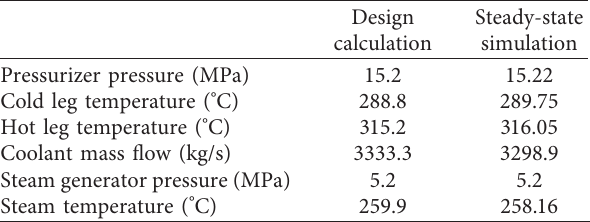
Table 2: Comparison of design calculation and simulation results.